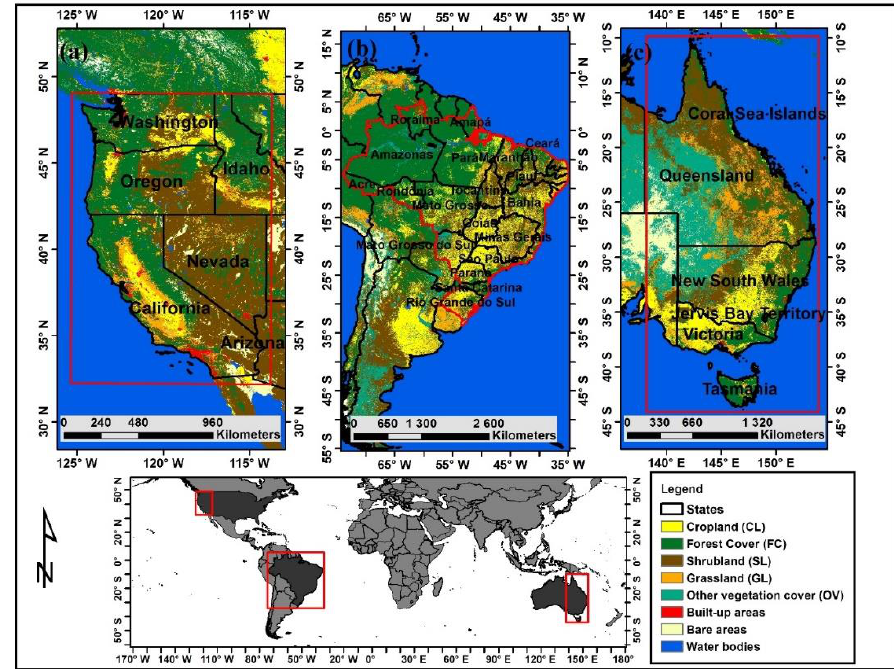
Figure 1. A map of the study area showing three study sites: ( a ) the western USA, ( b ) Brazil and ( c ) eastern Australia. The broad land cover distributions for 2018 are shown based on European Space Agency (ESA) Climate Change Initiative-Land Cover (CCI-LC) (http://maps.elie.ucl.ac.be/CCI/viewer/download.php).